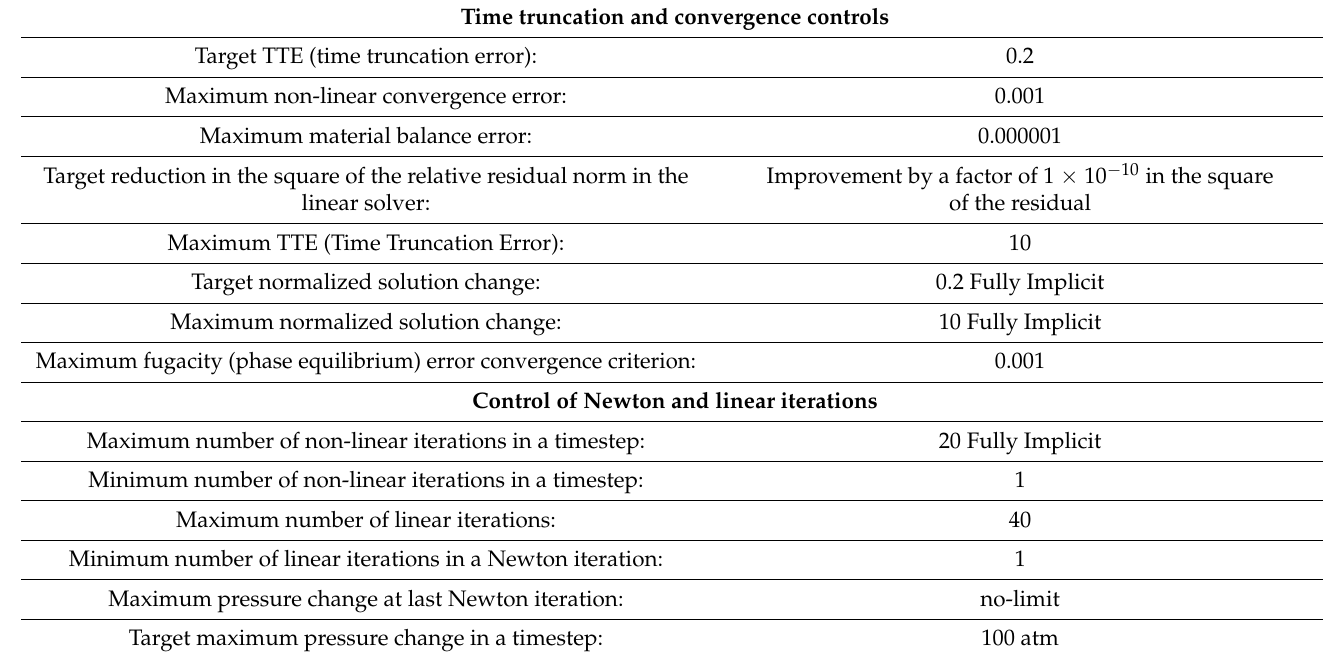
Table 2. Solver constraints and convergence controls used in the simulator. Time truncation and convergence controls